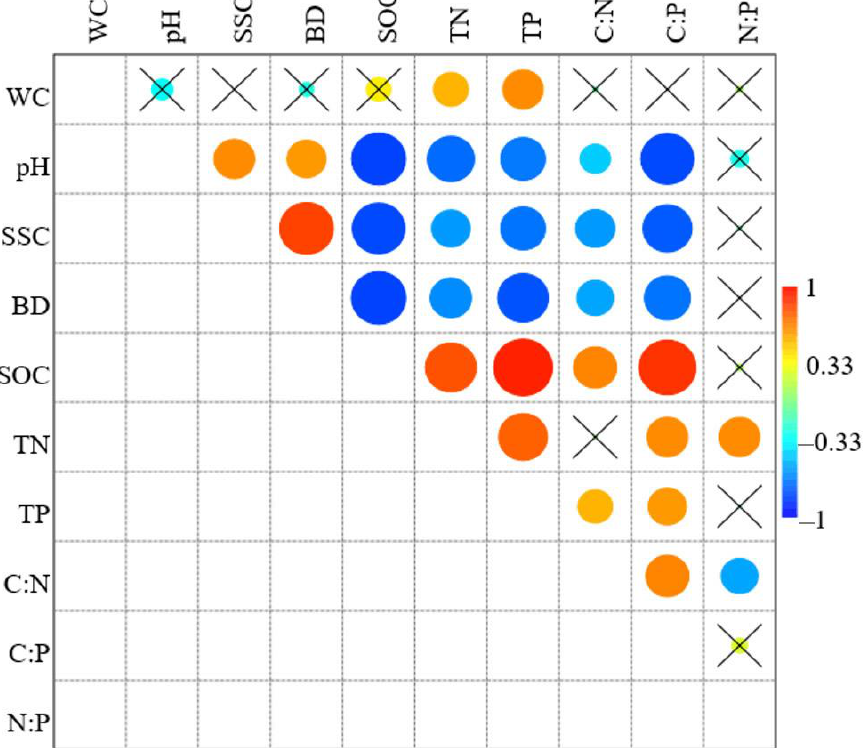
Figure 4. Pearson’s correlations among the topsoil properties and stoichiometric characteristics. The size of the circle is proportional to the r value, and the coefficient of correlation was marked in the color gradient. The “×” mark indicates no significant Pearson correlation ( p ≥ 0.050).